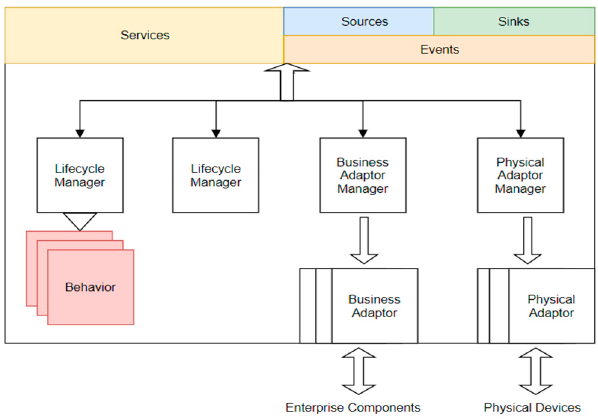
Figure 3. Block diagram of an intelligent entity instance.